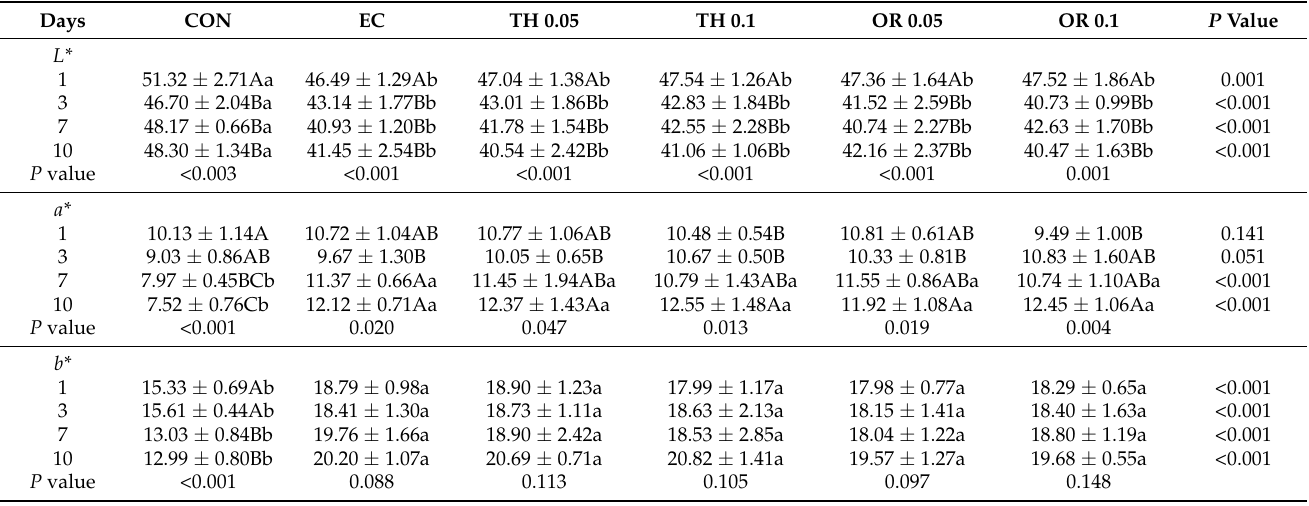
A, B, C: different upper letter means statistical differences between treatments within display ( P < 0.05). a, b, c: different lower letter means statistical differences between displays within treatment ( P < 0.05). CON: patties uncoated; EC: patties with edible coating; TH 0.05: patties with edible coating with 0.05% thyme EO; TH 0.1: patties with edible coating with 0.1% thyme EO; OR 0.05: patties with edible coating with 0.05% oregano EO; OR 0.1: patties with edible coating with 0.1% oregano EO. The influence of coating on the color of hamburgers L*, a* and